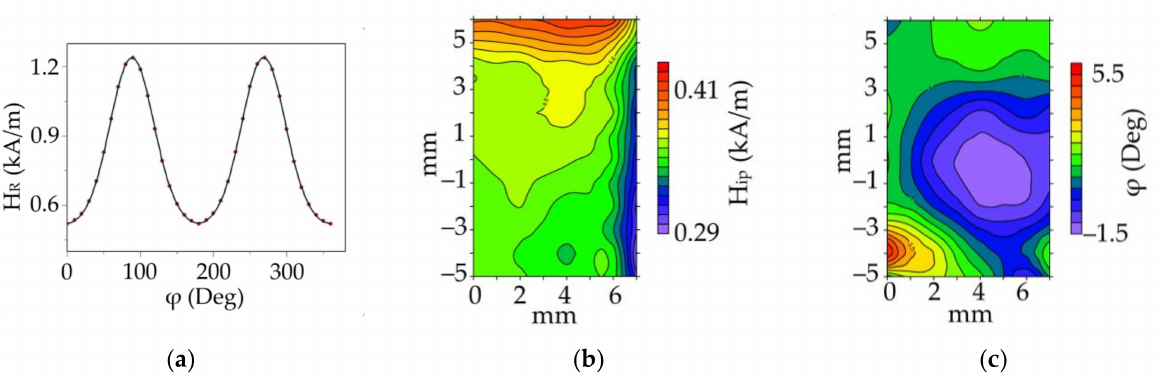
Figure 3. The angular dependence of the resonant field of a pixel in the center of the single-layer film of Py (100 nm) ( a ) Inhomogeneity of the uniaxial magnetic anisotropy field in the plane of thesingle-layer film of Py (100 nm) ( b ) Orientation inhomogeneity of the in-plane easy axis in the plane of the single-layer film of Py (100 nm) ( c ) Deviation from the average in-plane easy